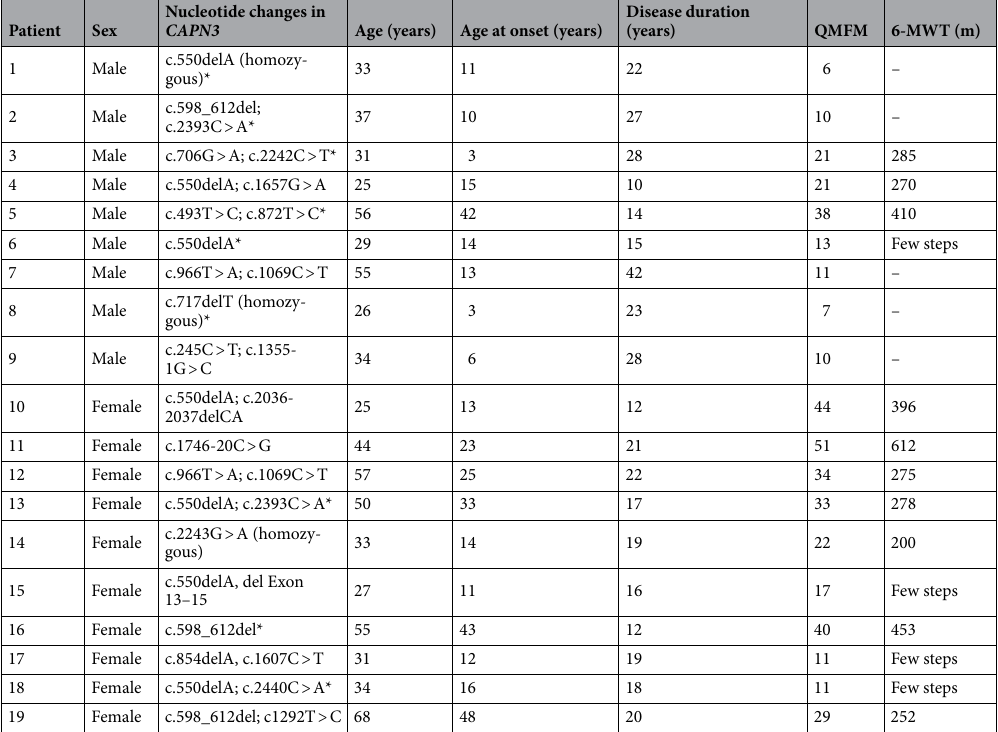
Table 1. Demographic and clinical data of patients with calpainopathy. *Diagnosis confirmed via muscle biopsy and reduced Calpain-3 protein abundance investigated by